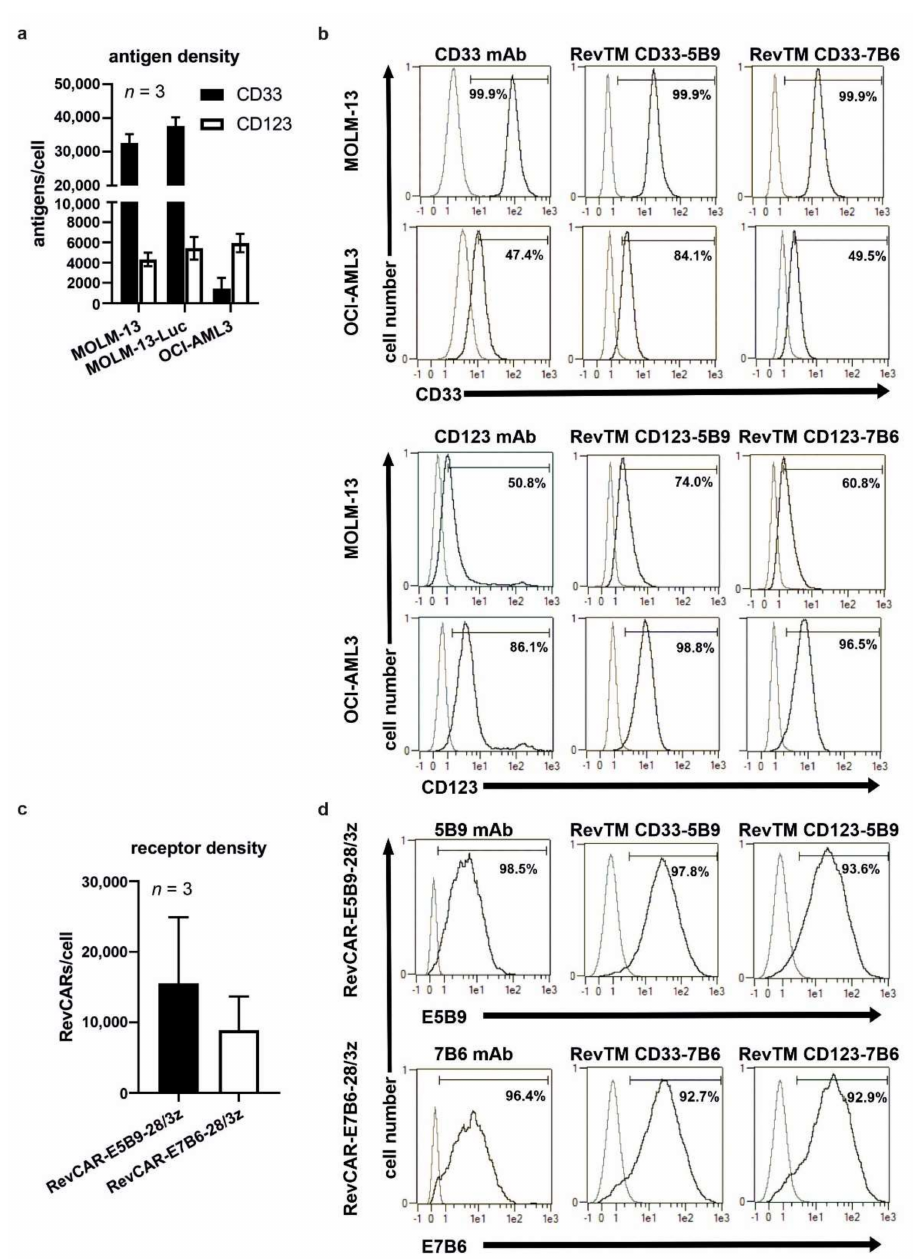
Figure 2. Expression of target antigens and RevCARs and binding capability of RevTMs. ( a ) Number of tumor-associated antigens CD33 or CD123 presented on the surface of MOLM-13, Luciferase (Luc) expressing MOLM-13-Luc or OCI-AML3 cells is shown for three individual experi- ments as mean ± SD. ( b ) Expression of CD33 and CD123 on MOLM-13 and OCI-AML3 cells was confirmed by flow cytometry after staining with APC-conjugated anti-CD33 mAb or PE-conjugated anti-CD123 mAb. Binding of His tagged RevTMs on AML cells was detected via FITC-conjugated anti-His mAb. ( c ) Number of RevCAR-E5B9-28/3z or RevCAR-E7B6-28/3z on RevCAR modified T-cells is quantified for three independent T-cell donors and represented as mean ± SD. ( d ) Ex- pression of RevCAR-E5B9-28/3z or RevCAR-E5B9-28/3z on modified T-cells was confirmed by staining with anti-E5B9 mAb or anti-E7B6 mAb and PE-conjugated anti-mouse-IgG mAb. Binding of indicated RevTMs to RevCAR-E5B9-28/3z or RevCAR-E5B9-28/3z presenting T-cells was detected using PE-conjugated anti-His mAb. ( b , d ) Stained cells (black lines) and respective controls (grey lines) are presented as histograms. Percentage of positively stained cells is